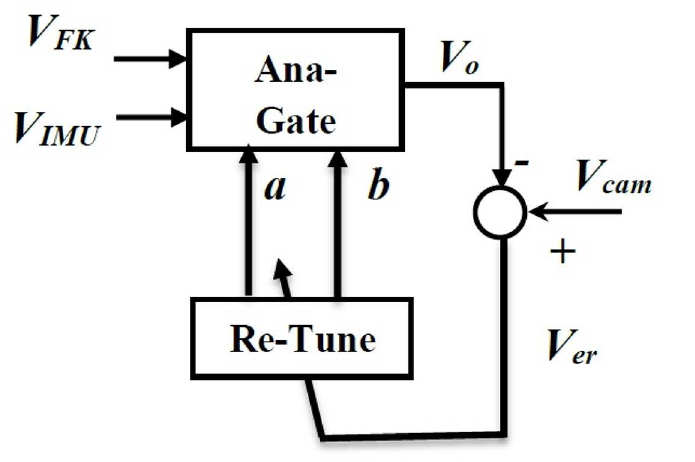
Fig 11. Tuning analogical gate.